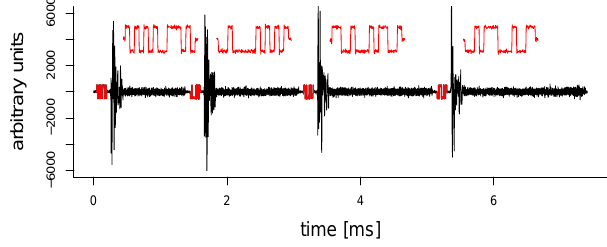
Fig. 1. Raw data of a full transmission cycle from experiment 1. Transmission signals are marked with red color. After each pulse a larger image of the transmission envelope is plotted above the received signal.